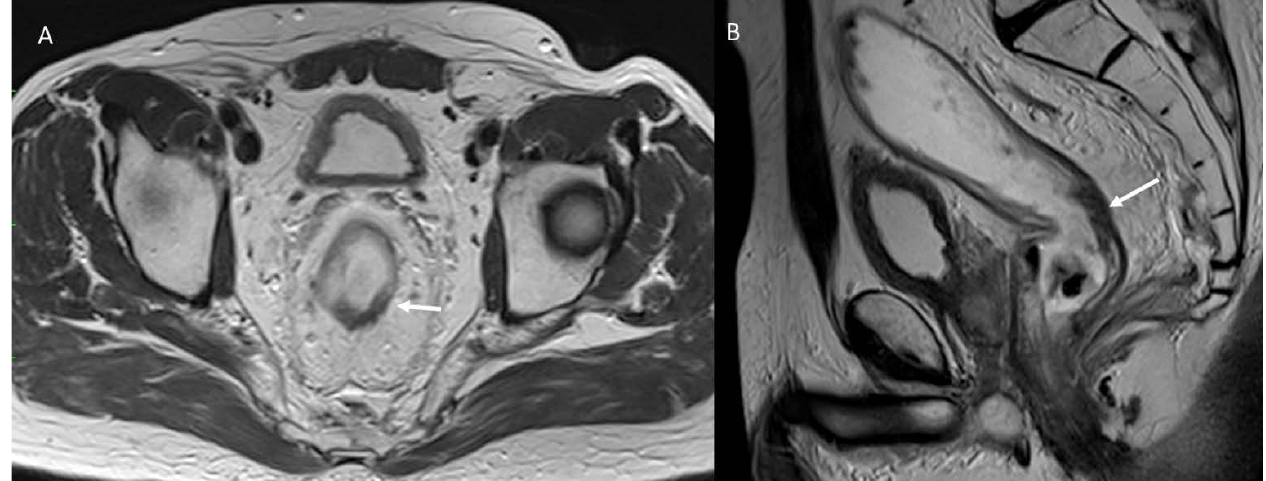
Figure 4. MRI assessment post n-CRT treatment: fibrotic response in T2-W axial (arrow) ( A ) and sagittal plane (arrow) ( B ).